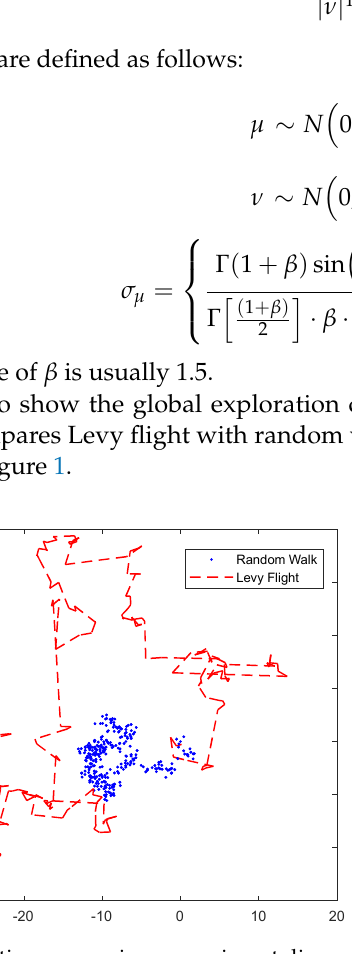
Figure 1. Simulation comparison experiment diagram of Levy flight and random walk.